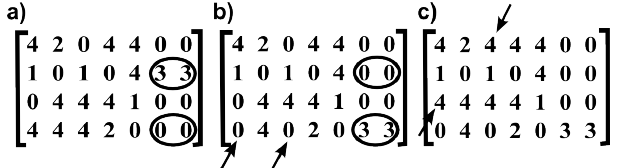
Fig. 2. The swap-shift